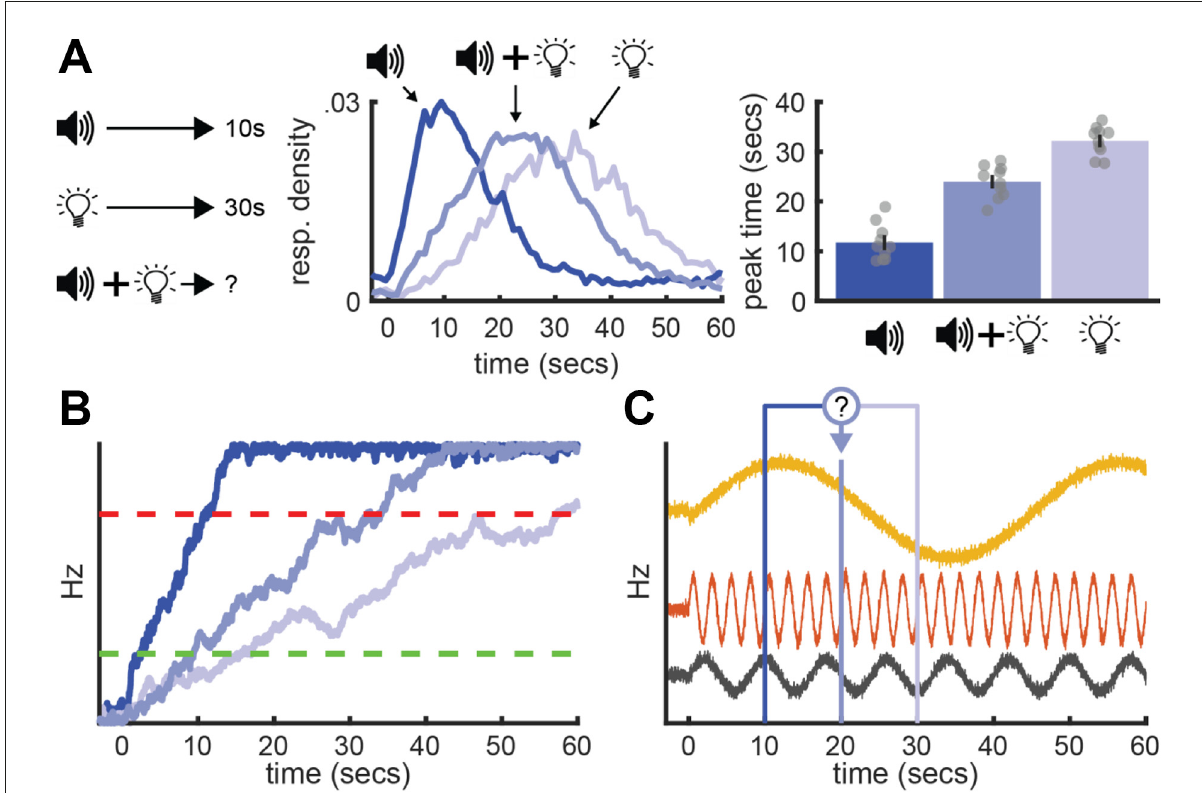
FIGURE6 Temporal averaging and neural models of timing. (A) Temporal averaging behavior. Left: Example task-schematic for a temporal averaging experiment. Middle: Mean response rates across time during each trial type. Right: Peak-times for each trial type. Data adapted from De Corte (2017). (B) Typical account of temporal averaging under a ramping model, wherein a ramping neuron takes an intermediate slope during compound trials. (C) Application of a population-clock model (here, SBF) to temporal averaging. The question-mark emphasizes the ambiguity over how two population patterns could be integrated to yield a pattern between the two target times.